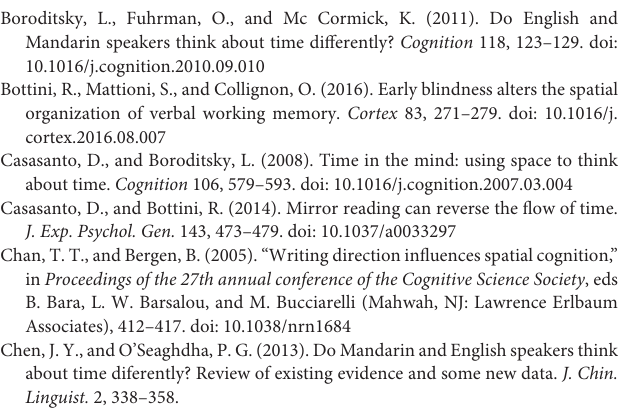
Supplementary Figure 1 | Order diagram of event occurrence. Each set of cards included 3 cards (12 cm × 12 cm) which represented the early, middle and late states of the event. Supplementary Table 1 | Results Record Table of Card sorting task (Section). First record the judgment of the two small cards as “start” or “last”, correctly call √ √ √ “ ” under “R” and “ ” under “W”; then call “ ” in the corresponding position in the table in the direction represented by the display itself. Supplementary Table 2 | Record table of implicit and explicit task results √ (section). According to the placement results of the subject, play “ ” in the corresponding position in the table according to the direction of the placement